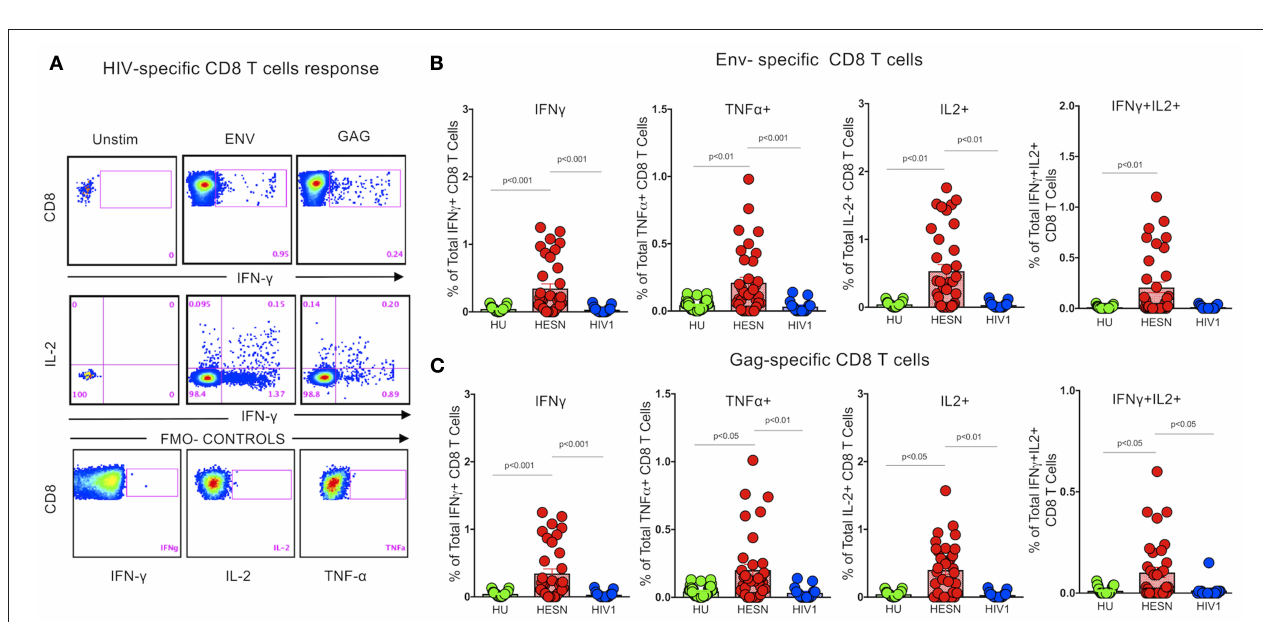
FIGURE 2 | Abundance of CXCR5 + CD8 + T cells and stem-like memory CD8 + T cells in HIV-1 exposed seronegative women. (A) Representative flow plots showing the % frequency of CXCR5 + T cells and TSCM cells in the study groups (HESN— N = 35, HIV + ART + – N = 10, HIV + ART − – N = 10 and HU— N = 35). (B) Figure showing the cumulative frequency of CCR7 − CD28 + CD95 + stem cell-like memory subset of CD8 + T cells in the HESN, HIV + ART + , HIV + ART − and HU groups. (C) Figure showing the cumulative frequency of CXCR5 + CD8 + T cells in the HESN, HIV + ART + , HIV + ART − and HU groups. The scatter dot plots summarize the % frequency of total CD8 + CXCR5 + T cells and TSCM cells (median, 1st, and 3rd quartiles). p- values were calculated using the K-Wallis test. Sub-group analysis was performed using Dunn’s test.